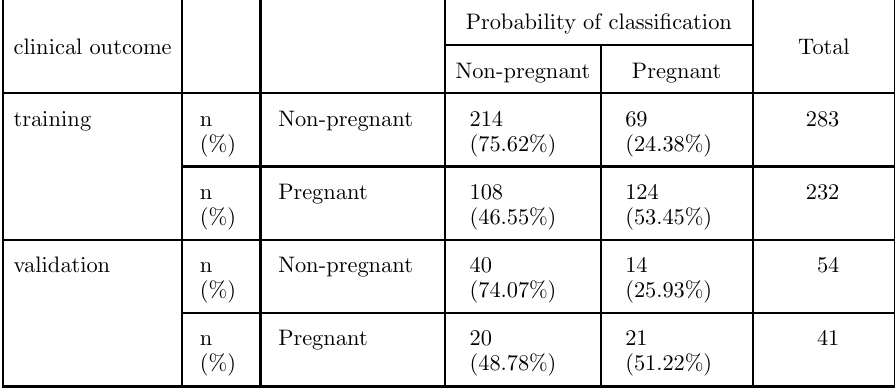
Table 3. Matrix of correct classifications (training set, validation